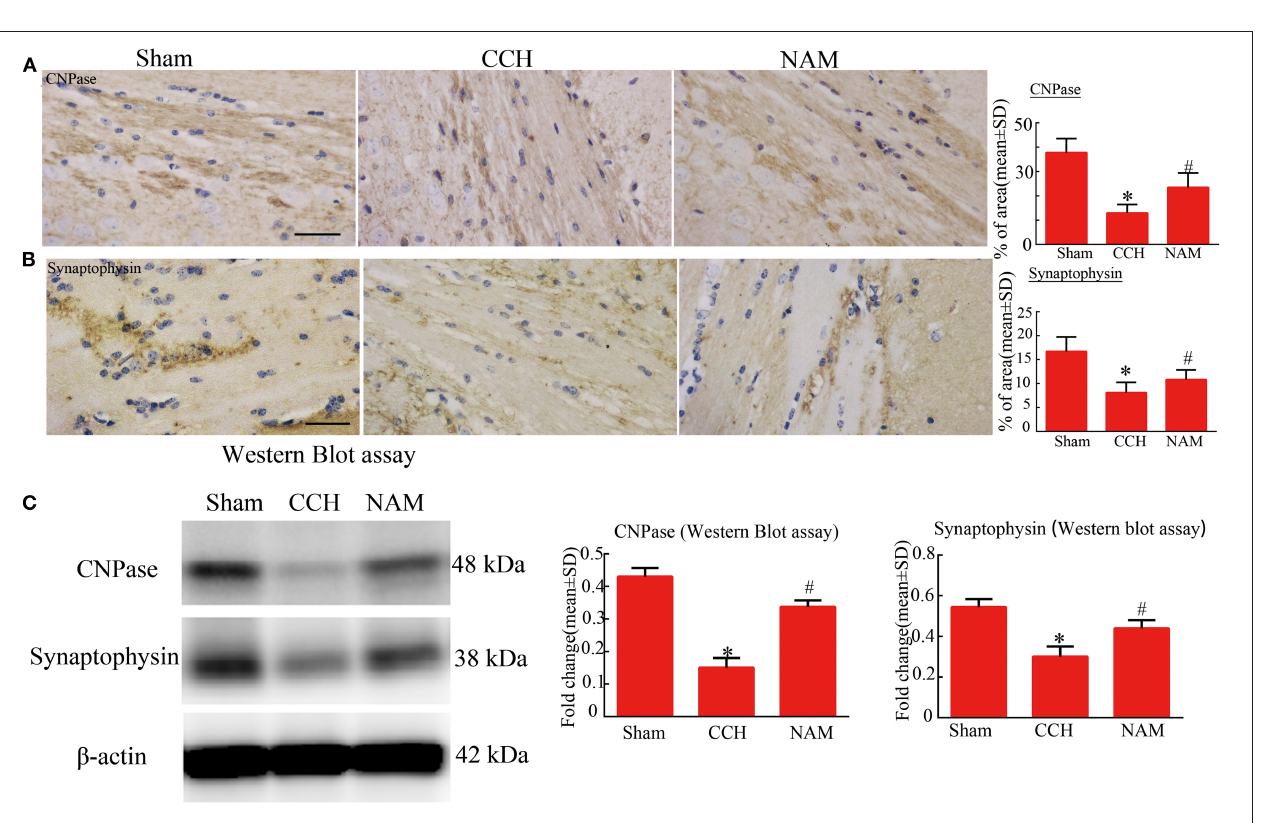
FIGURE 5 | Effect of NAM on white matter remodeling and synaptic plasticity ( n = 4/group). (A) : Expression of CNPase as measured via immunohistochemical staining (scale bar = 50 µ m); (B) : Expression of synaptophysin as measured using immunohistochemical staining (scale bar = 50 µ m); and (C) : Levels of expression of CNPase and synaptophysin proteins as measured via Western blotting. * p < 0.05, compared with sham group; # p < 0.05, compared with CCH group. (33). In this study, histopathological examination of brain is the most prominent of all the pathological changes due to CCH (32). Cognition has been linked to brain frontal tissues of CCH mice revealed decreased myelin density and subcortical circuits and periventricular white matter junction extensive vacuole-like changes in the corpus callosum